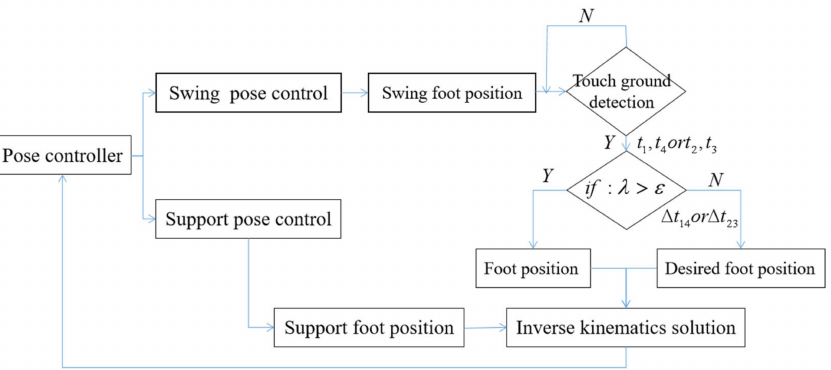
Figure 8. Gait adjustment strategy